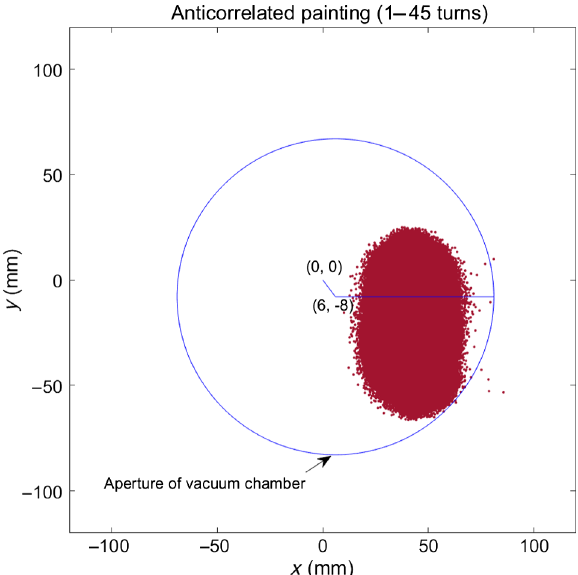
FIG. 3. Simulation results of the circulating beam distribution at the magnet BH3 in the initial stage of injection for the anticorrelated painting.